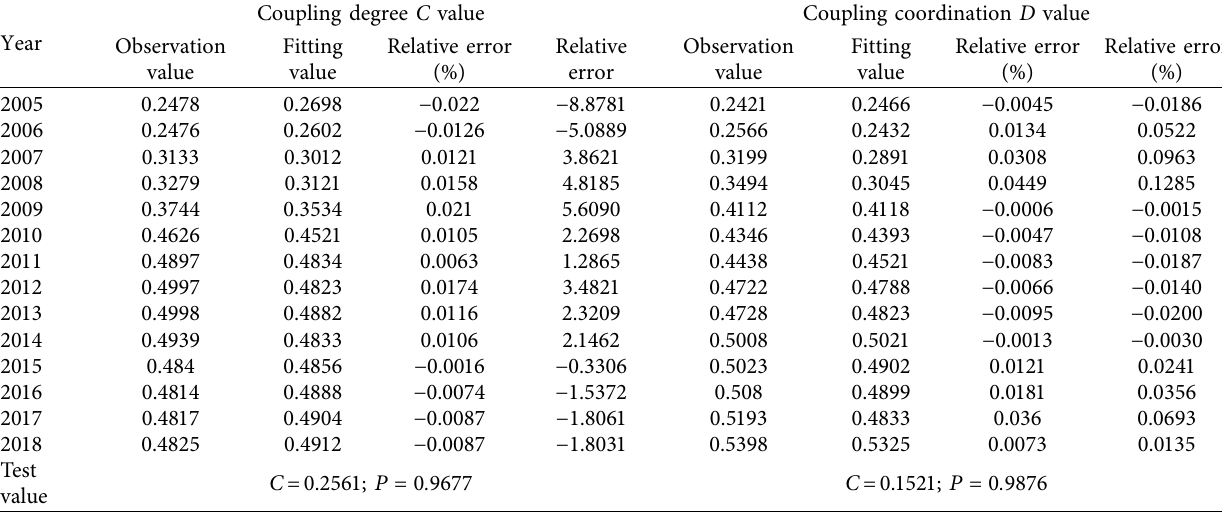
Table 5: Error test based on the GM (1.1) gray prediction model.